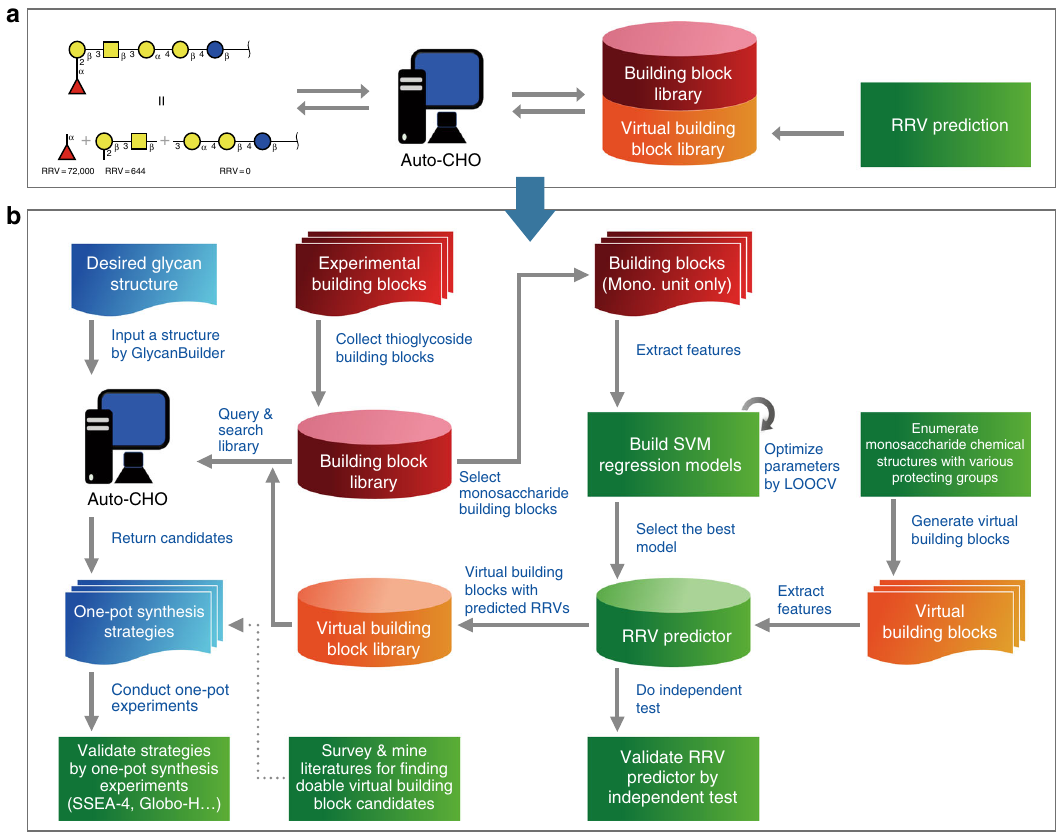
Fig. 1 The work fl ow of Auto-CHO program. a The basic concept of Auto-CHO. b The detailed work fl ow. Auto-CHO allows users to input a desired glycan structure and the program returns with one-pot glycan synthesis options. To facilitate the ability of Auto-CHO, we have not only expanded the thioglycoside BBLs but also constructed a virtual BBL library by enumerating monosaccharide structures with different protecting group combinations and theoretical RRVs that are estimated by our RRV predictor. RRV predictors are trained by SVM regression models, and features from experimental BBLs with known RRVs. The predictor with the best performance by leave-one-out cross-validation (LOOCV) has been chosen as the fi nal model. Independent test has also been applied to validate the result. Since the use of virtual BBL in glycosylation may not have been validated and it is uncertain if it can be successfully used in the one-pot synthesis process, text mining could be used to identify those virtual BBL candidates that have been reported in literature and thus, have a good chance of participating in the one-pot synthetic reaction. The synthetic methods provided by Auto-CHO have been further validated by four synthetic experiments in this study